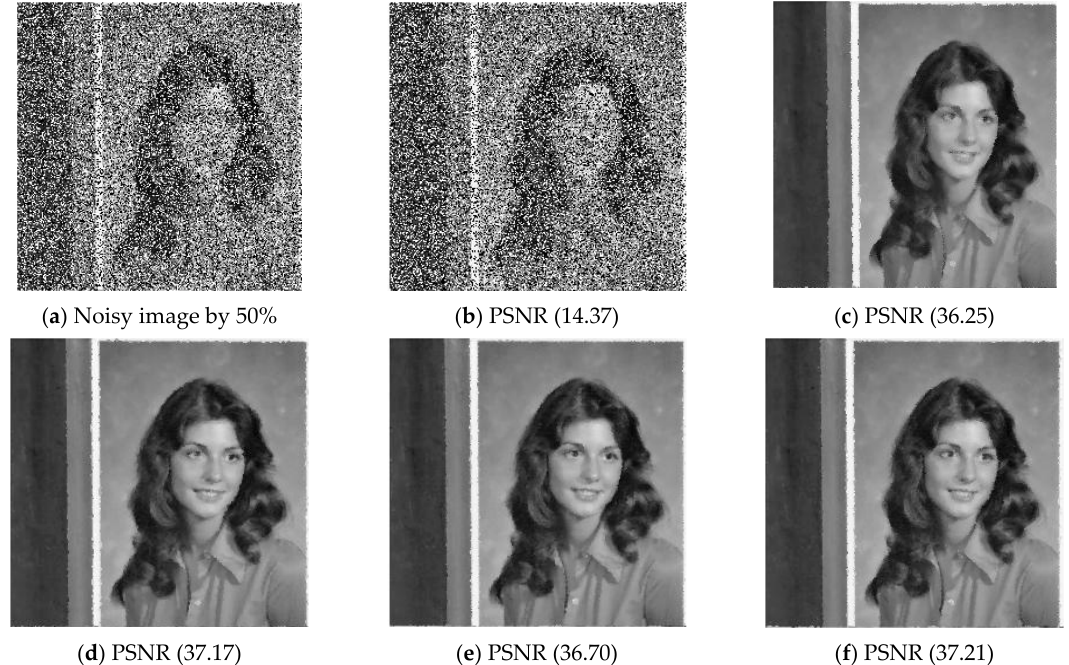
Figure 4. Noised “ Girl ” image by 50% fixed value impulse noise and its restored images by different state-of-art and their PSNR. ( a ) Noisy “ Girl ” image ( b ) EDF+BDND ( c ) IGMF+FTD ( d ) ASWMF+D3PLS ( e ) NBMF+VTD ( f ) The proposed state-of-art.